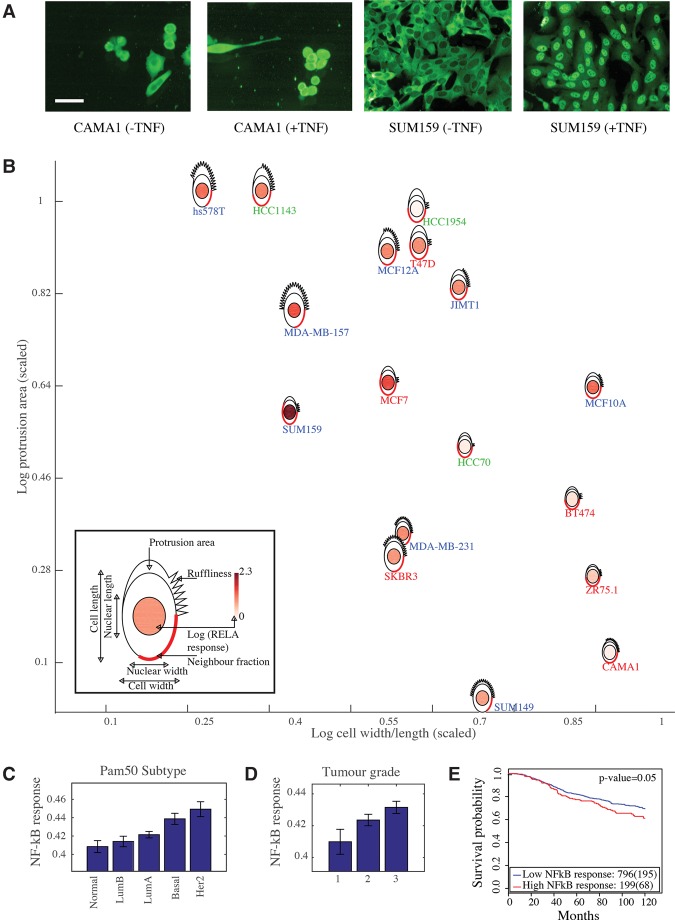
Derivation of NF-κB response metagene and its association with the clinical parameters in the METABRIC data set. (A) CAMA1 and SUM159 cells stained with anti-RELA/NF-κB antibody (−/+TNF). Scale bar = 50 µm. (B) Representation of seven morphological BCL features and RELA response (fold change +TNF/−TNF) using PhenoPlot (Sailem et al. 2015), where BCL glyphs are positioned based on the value of cell W/L (x-axis) and protrusion area (y-axis). Cell line label color indicates molecular subtype. Red: luminal, green: basal A, and blue: basal B. (C) Association between Pam50 subtype and NF-κB response metagene (Jonckheere–Terpstra test P-value < 0.0005). Error bars indicate the SEM. (D) Association between tumor grade and NF-κB response metagene (Jonckheere–Terpstra test P-value < 0.0005). Error bars indicate the SEM. (E) Kaplan–Meier curves to illustrate the disease-specific survival probabilities of patient groups in the discovery cohort in the METABRIC data set, stratified by NF-κB response metagene.